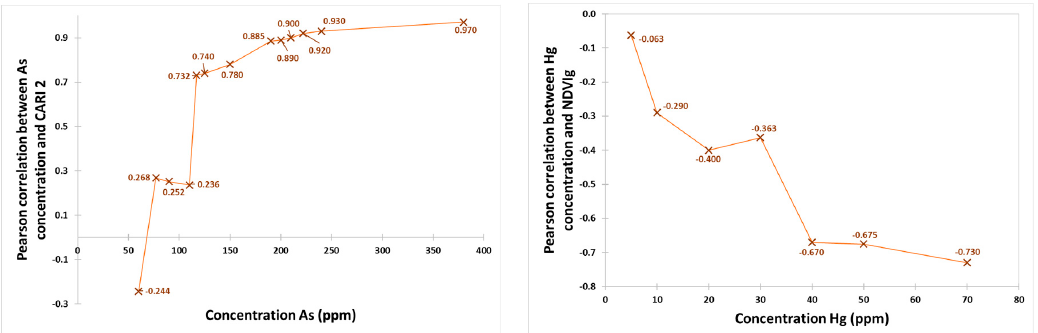
Figure 5. Pearson’s coefficients between the concentration of As and CARI-2 vegetation index (left) and Hg and NDVIg vegetation index (right).